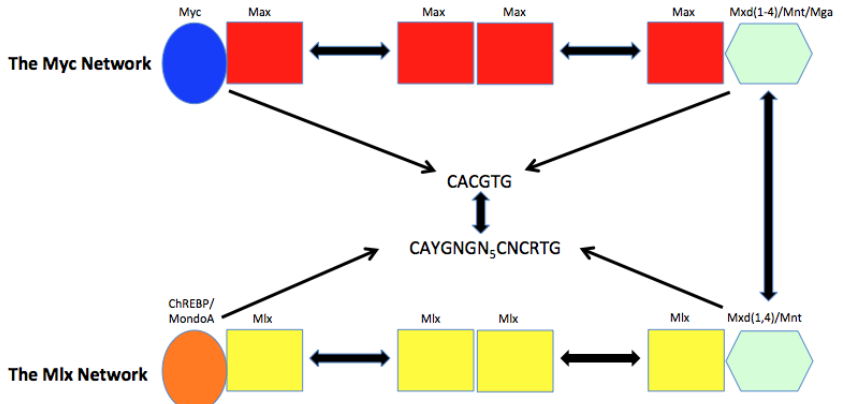
Figure 1. The Myc and Mlx Networks. Inactive as a monomer and unable to homodimerize under physiologic conditions, Myc binds to target gene consensus E-boxes (CACGTG) only after heterodimerizing with Max [9,22]. This leads to the de novo acetylation and methylation of specific histone residues, the relaxing of chromatin structure and target gene transcriptional activation following the Myc-dependent recruitment of scores of transcriptional cofactors [9,23–25]. Although Max homodimerizes and binds DNA well in its unmodified form, its ability to do so within cells is low due to inhibitory casein kinase II-mediated phosphorylation [26,27]. Transcriptional silencing is mediated by six “Mxd proteins” (Mxd [1–4], Mnt and Mga), which compete with Myc for Max, displace Myc-Max heterodimers from E-boxes, recruit histone deacetylases and reverse the above-described histone modifications [9,18,23]. In the Mlx Network, the Myc-like factors ChREBP and MondoA homodimerize poorly but heterodimerize well with the Max-like factor Mlx. However, they enter the nucleus and engage E box-related ChoRE sites (CAYGNGN 5 CNCRTG) only after binding glucose, glucose-6-phosphate, fructose-2,6-bisphosphate, lactate or adenosine [9,28–36]. The reversal of ChREBP/MondoA target gene activation is mediated by heterodimers between Mlx and Mxd1, Mxd4 and Mnt, thus allowing communication with the Myc Network. Further cross-talk derives from the fact that Myc and Mlx Network members may bind one another’s target genes under certain circumstances